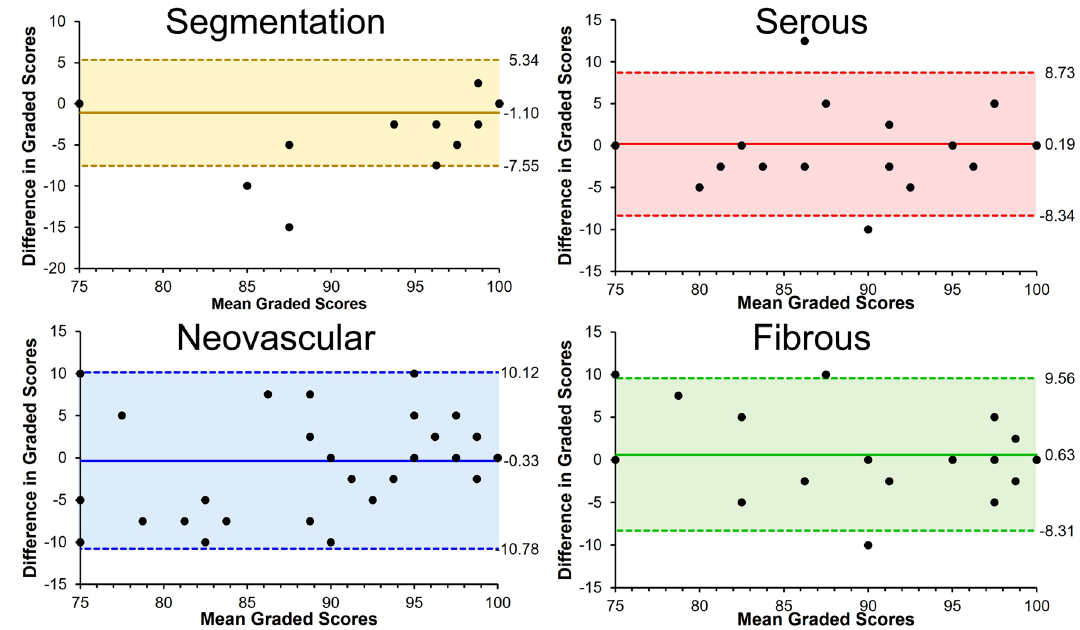
Figure 4. Bland–Altman plots capturing the difference in graded scores between two expert clinicians in evaluating accuracy of segmentation and classification of serous, neovascular, and fibrous components of pigment epithelial detachments (PED). Shaded areas capture two standard deviations from the mean. Significant outliers in segmentation scores demonstrated disagreement of neovascular vs non-neovascular PED.